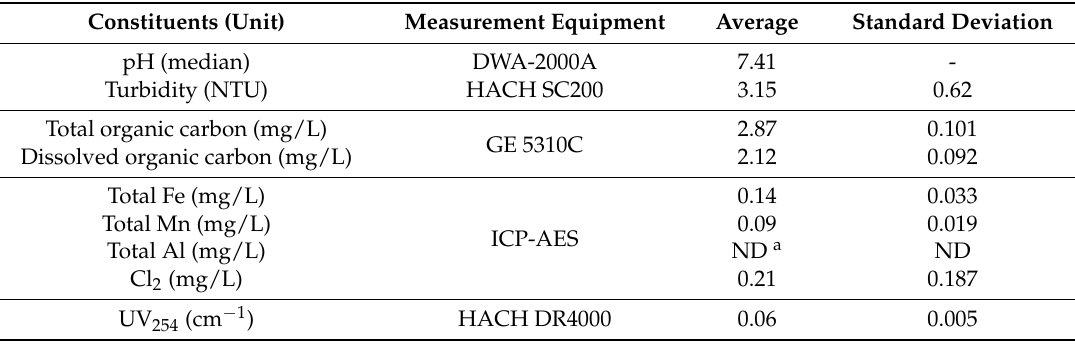
Table 1. Concentrations and measurement equipment of raw water.